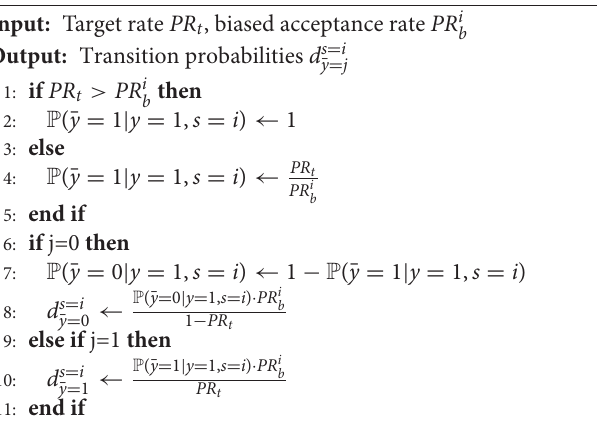
Algorithm 2 : Targeting a balanced